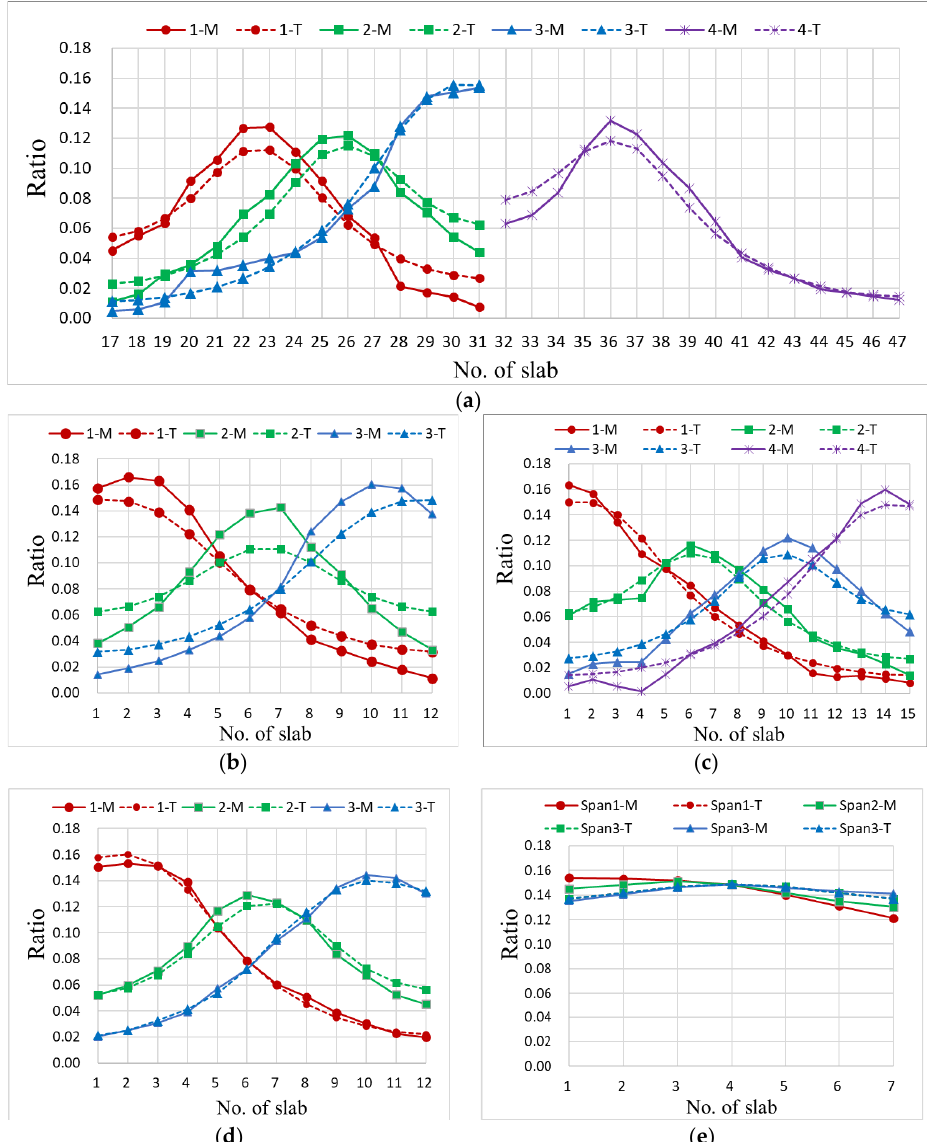
Figure 7. Lateral load distribution ratio of different spans. ( a ) First span of Luojiagang Bridge. ( b ) First span of Qingling 5# Bridge. ( c ) First span of Dadongmen Bridge. ( d ) First span of Yezhi Bridge. ( e ) First, Second, and Third span of 8# Ramp Bridge.